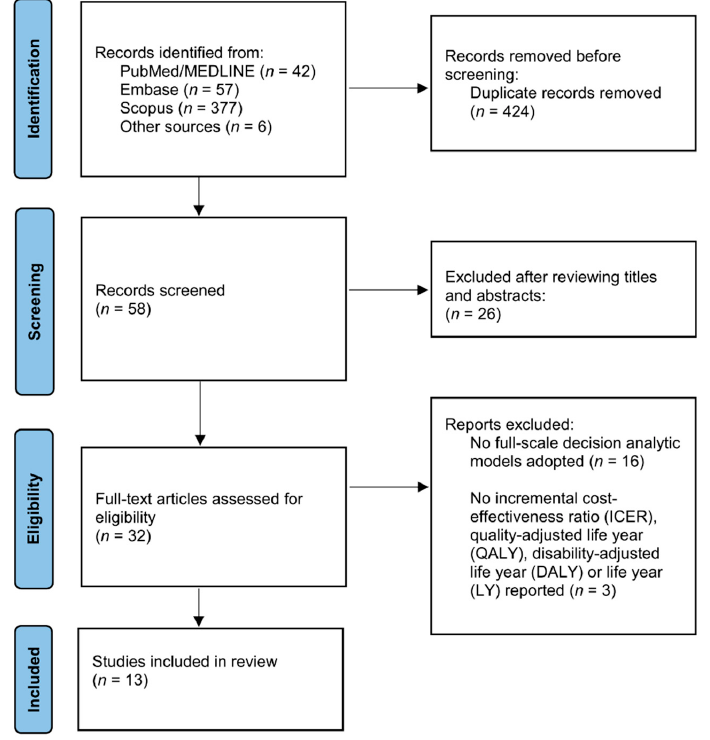
Figure 1. The literature search flow diagram.